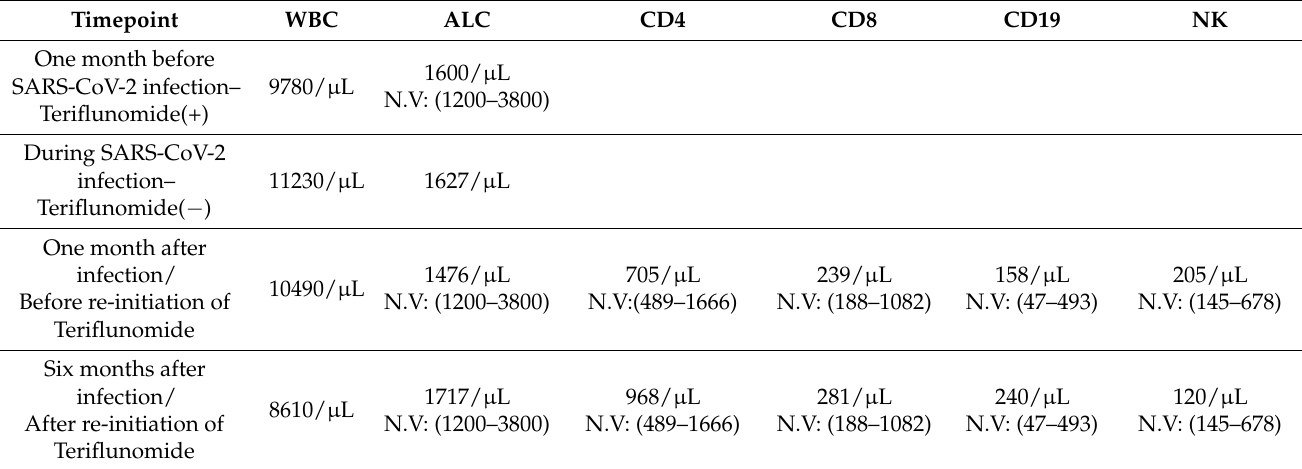
Table 2. Lymphocyte immunophenotyping and absolute lymphocyte count at various timepoints.